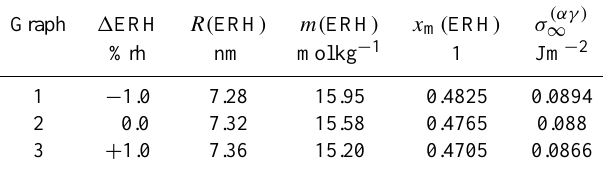
Table 1. Determination of the efflorescence radius R( ERH ) , the efflorescence molality m( ERH ) , the efflorescence mass fraction x m ( ERH ) , and the liquid/solid interface energy σ (αγ) ∞ according to